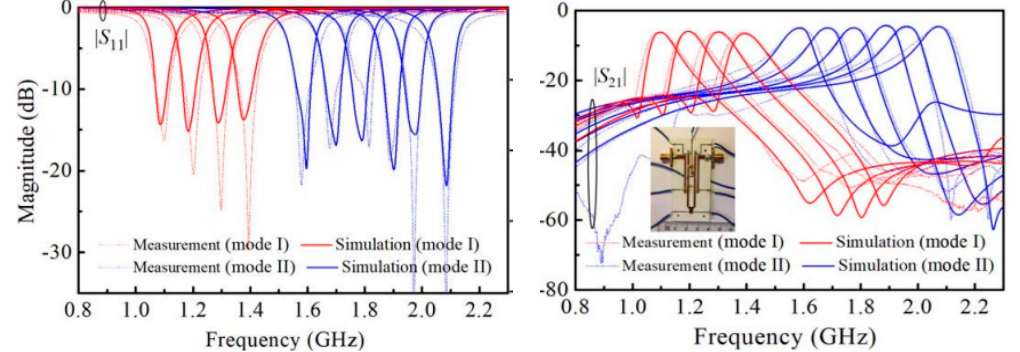
Figure 5. S-parameter performance of the reconfigurable filter reproduced from [33]. 2020, IEEE with a photograph of the fabricated prototype.